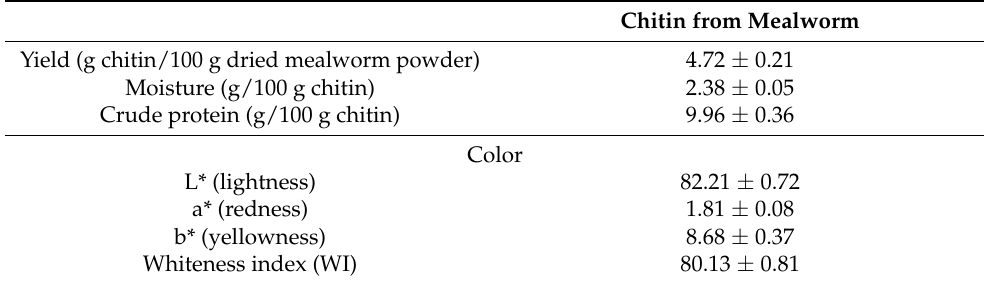
Chitin from Mealworm